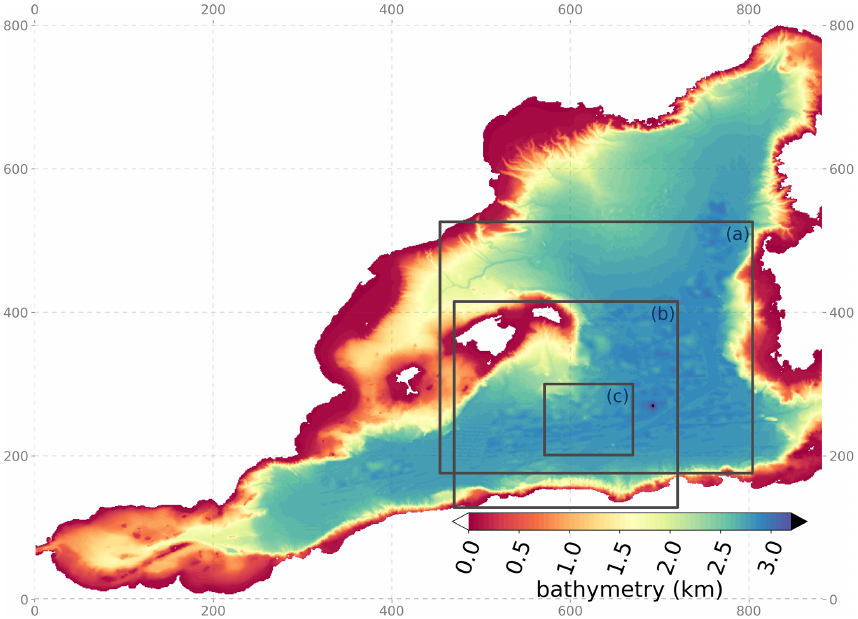
Figure 1. Bathymetry (in km) of the MEDWEST60 regional domain ( x and y axes are model grid points). The full domain covers 883 × 803 grid points in the horizontal, representing 1200km × 1100km, from 35.1 to 44.4 ◦ N in latitude and from 5.7 ◦ W to 9.5 ◦ E in longitude. The black squares localize three subregions which are referred to in the text and are used for various diagnostics or visualizations in the following. Table 1. Technical specifications of the MEDWEST60